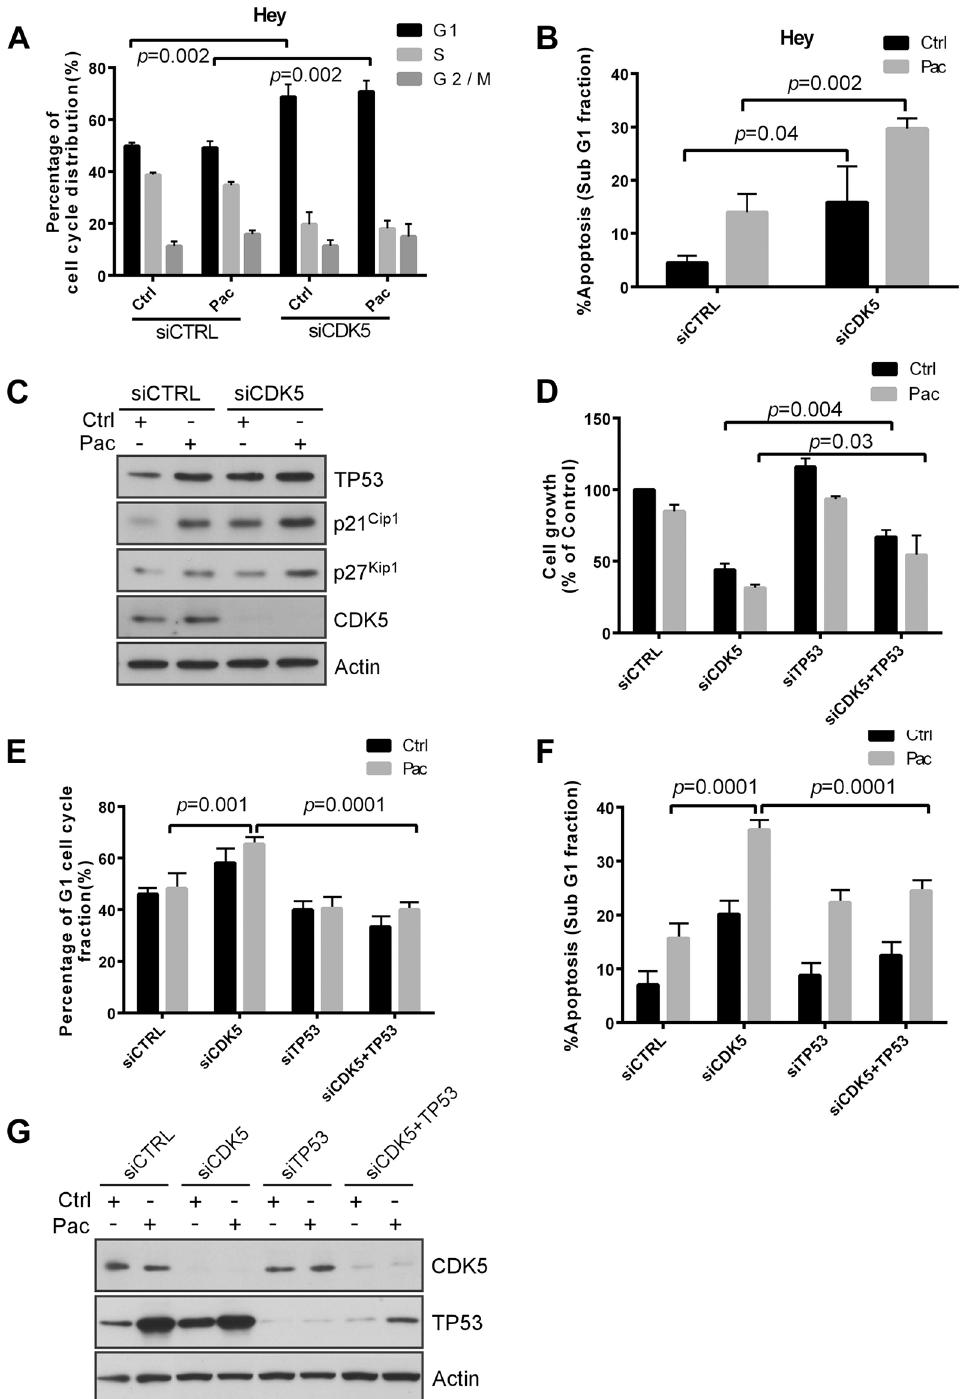
Fig 3. CDK5 knockdown induces p53-dependent growth inhibition, apoptosis and G1 arrest. ( A, B ) Knockdown of p53 reduced CDK5 knockdown- induced apoptosis (A) and G1 arrest (B). HEY cells were reverse transfected with control siRNA or CDK5 siRNA for 24 h and treated with 5 nM paclitaxel (Pac) or diluent (Control) for an additional 48 h, and then cell cycle analyzed by flow cytometry. Data shown are mean values from three independent experiments. ( C ) CDK5 knockdown increased the expression of p21 Cip1 , p53, and p27 Kip1 . HEY cells were treated with control siRNA or CDK5 siRNA for 24 h and then with paclitaxel (3 nM) or diluent for 48 h. Immunoblot analysis was performed with antibodies against p21 Cip1 , p53, and p27 Kip . ( D ) Knockdown of p53 expression reduced CDK5 siRNA-induced growth inhibition and reduced the enhancement of paclitaxel sensitivity. Cells were co-transfected with CDK5 siRNA and p53 siRNA for 24 h and treated with paclitaxel (Pac) or diluent. Proliferation of cells was measured with a crystal violet cell proliferation assay. ( E,